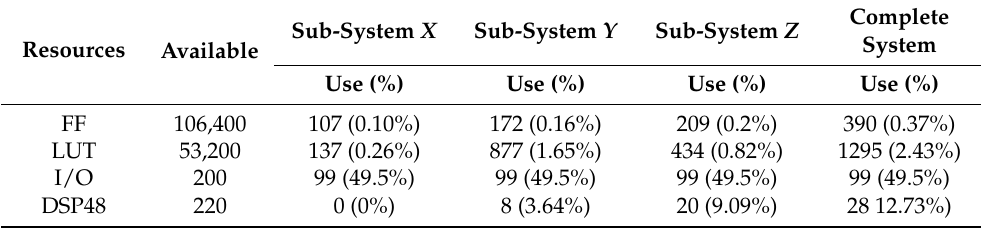
Table 2. FPGA resources use of sub-systems and complete chaotic oscillator